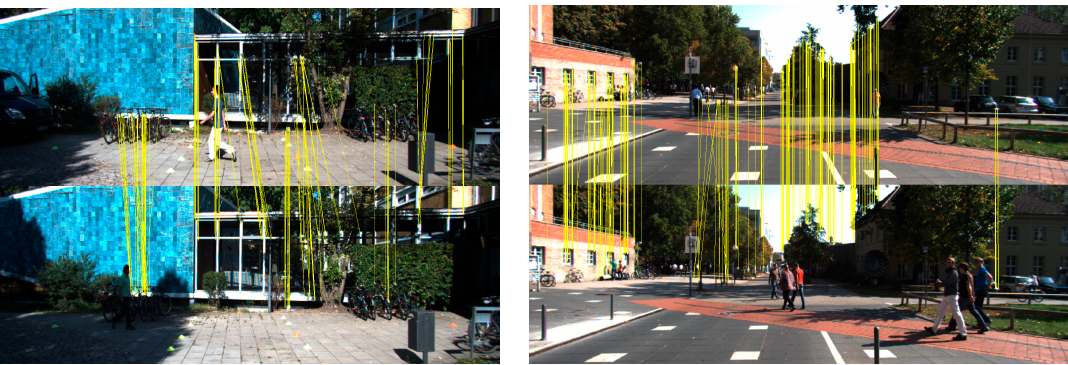
Figure 9. The successfully matching points after using the grid-based motion statistics (GMS) algorithm.